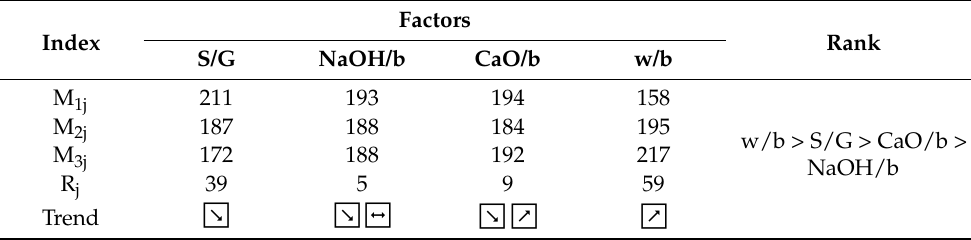
Table 6. Orthogonal extreme difference analysis of fluidity (mm).